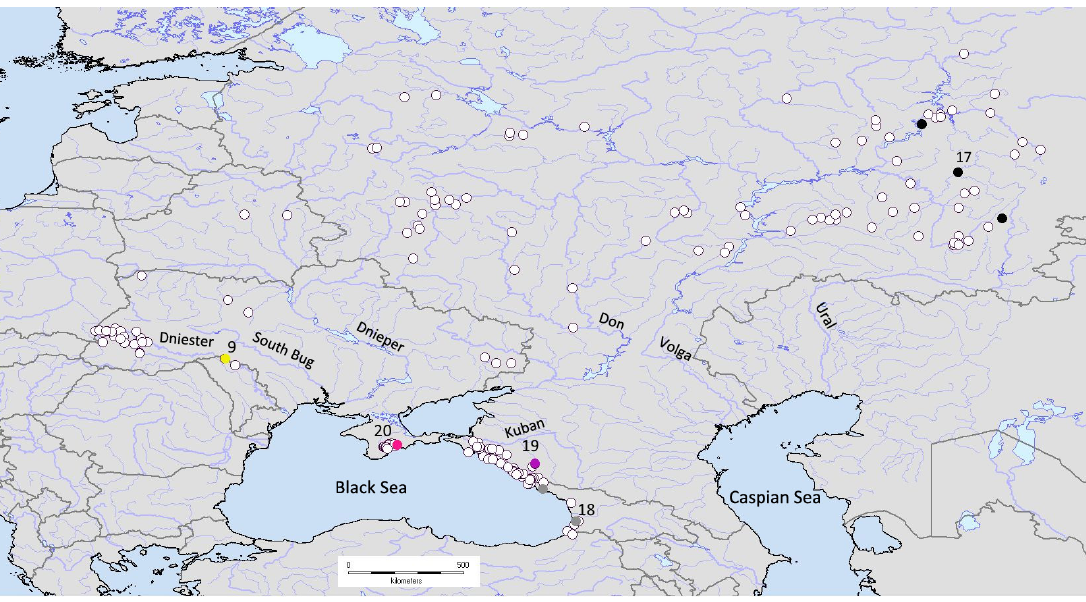
Fig. 1. Map of the localities of Phoxinus Agassiz, 1835 in river drainages of the northern and north-eas- tern coasts of the Black Sea and the Caspian Sea based on numerous published sources (references available in Supp. file 1) and public museum collections (Museum of Zoology, National Museum of Na- tural History, Kyiv, Ukraine; Natural History Museum, Vienna, Austria; Zoological Research Museum Alexander Koenig, Bonn, Germany). Coloured circles and numbers correspond to genetically examined individuals of clades specified in Palandačić et al. (2017, 2020): yellow circle = P. marsilii , Clade 9; black circles = ‘Baltic Phoxinus ’, Clade 17; grey circles = P. colchicus , Clade 18; purple circle = ‘Kuban Phoxinus ’, Clade 19; pink circle = ‘Crimean Phoxinus ’, Clade 20.